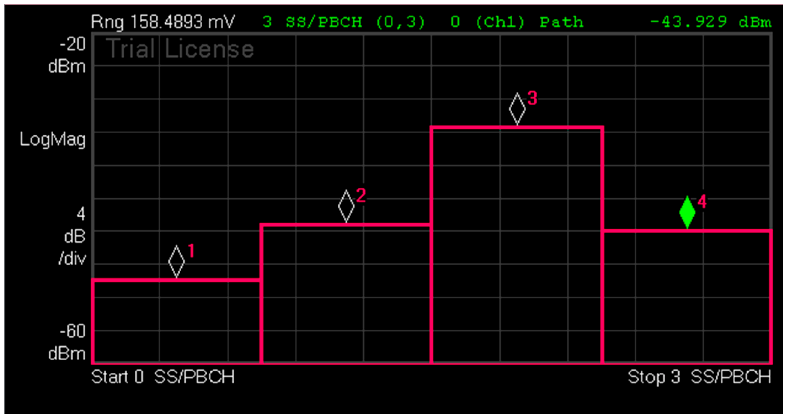
Figure 12. Received power level of SSBs for signal #3 where the effect of beam sweeping is simulated; due to a strong power de-boost, only four SSBs are